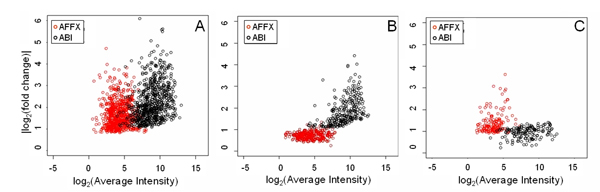
Genes found differentially expressed using AFFX and ABI. A) Set of 726 genes passing SAM statistical validation both in AFFX and ABI, B) Set of 182 genes passing SAM statistical validation only in ABI, C) Set of 204 genes passing SAM statistical validation only in AFFX. AFFX data are reported in red, ABI in black. The lack of statistical significance in one of the platforms (B, C) is also associated with a limited log2(Fold Change) variation. On the other hand, log2(Fold Change) variation for genes passing the statistical validation in both platforms (A) is quite similar, although ABI seems to have wider log2(Fold Change) dynamic range.